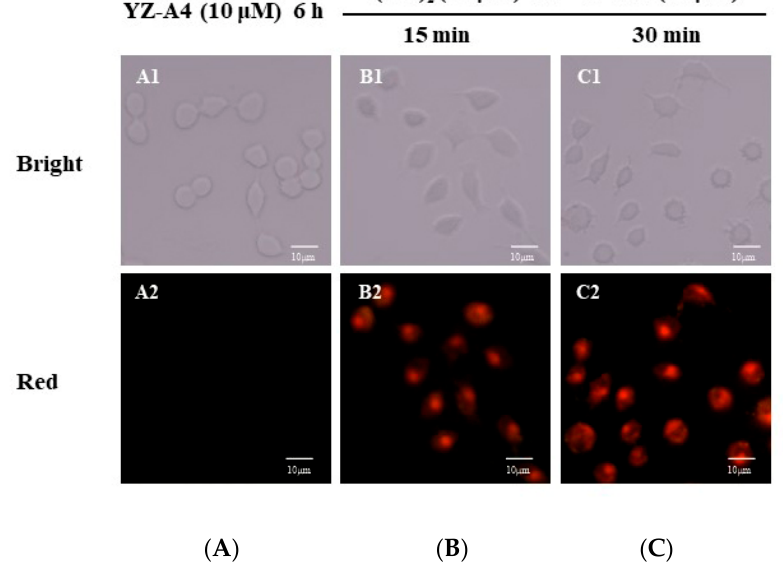
Figure 6. Fluorescence images of living A549 cells. The fluorescence was measured at a red channel. ( A ) 10 μ M YZ-A4 for 6 h, ( B ) 10 μ M (Sec) 2 for 6 h + 10 μ M YZ-A4 for 15 min, ( C ) 10 μ M (Sec) 2 for 6 h + 10 μ M YZ-A4 for 30 min. The scale bar is 10 μ m. Red channel, excitation from 540 to 565 nm and emission from 605 to 655 nm.